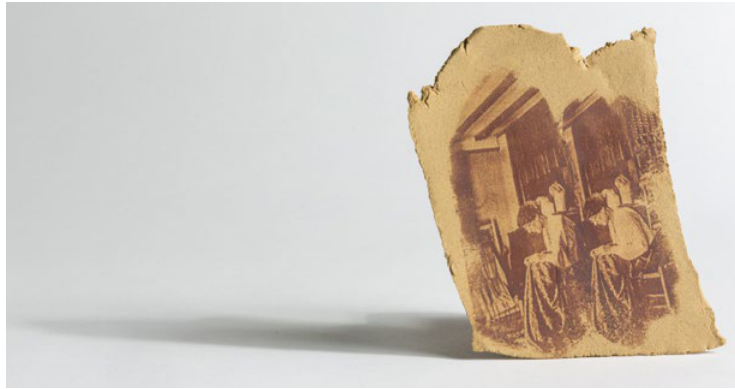
Figure 8.7 Reconstruct. Oxide print on stoneware clay (15.5 × 10.5